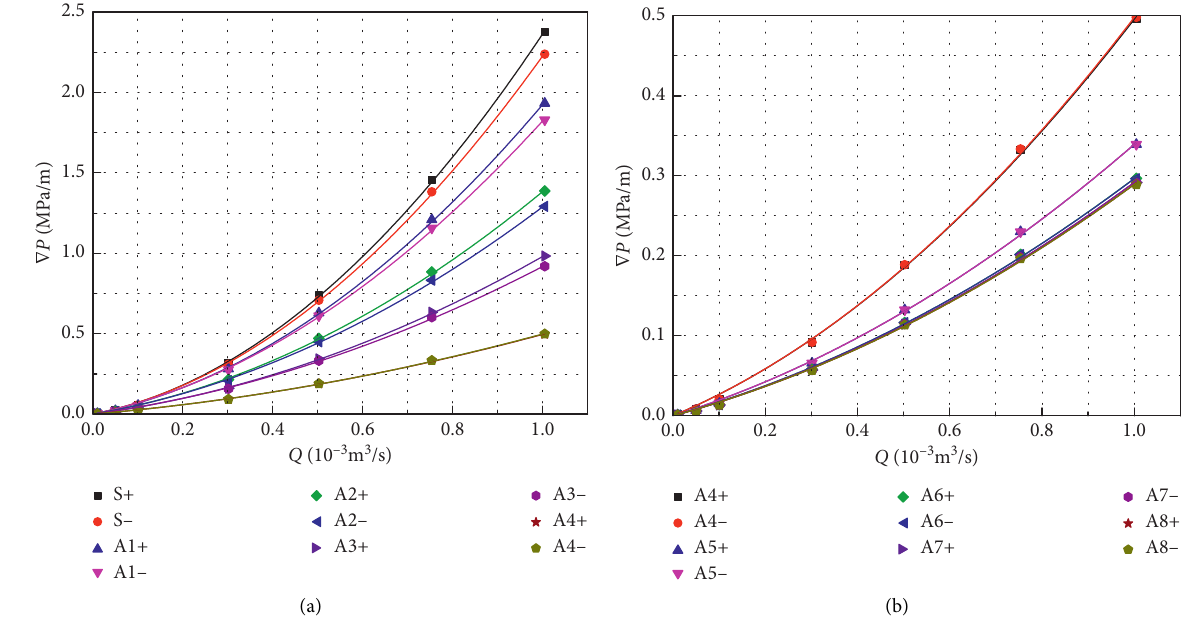
Figure 6: Analysis of nonlinear seepage Table 1: Statistical table of non-Darcy fitted parameters at different scales.